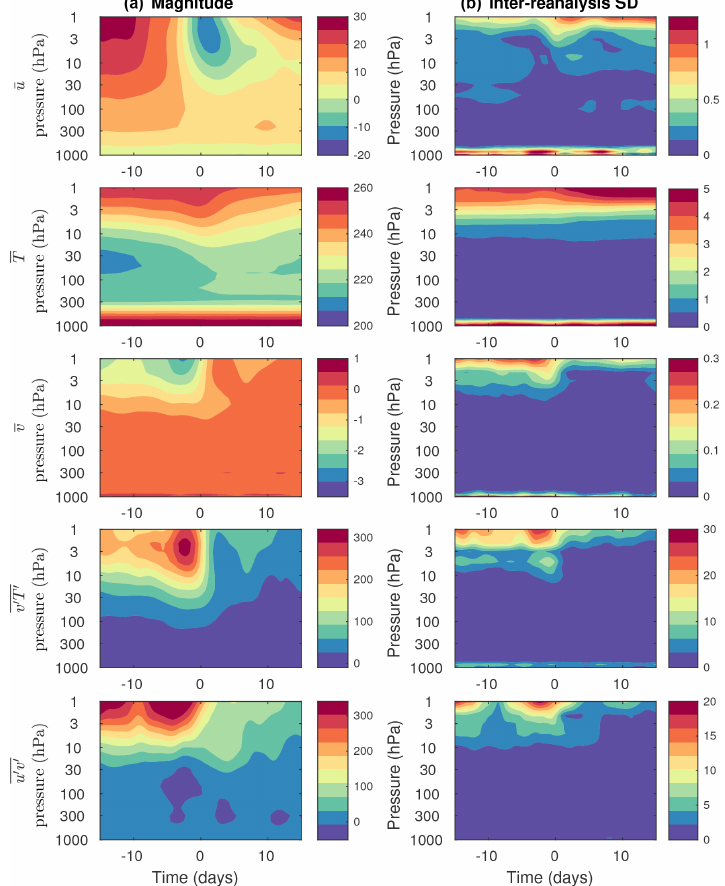
Figure 3. Evolution of zonal-mean variables and eddy fluxes during SSW events (rows) in function of pressure and time. All quantities are averaged from 45 to 85 ◦ N. The LRE mean is shown to the left and the LRE standard deviation is shown to the right. Zonal wind ( u ) and meridional wind ( v ) have units of ms − 1 . Temperature ( T ) has unit of K. Heat flux ( v (cid:48) T (cid:48) ) has unit of mKs − 1 . Momentum flux ( u (cid:48) v (cid:48) ) has units of m 2 s − 2